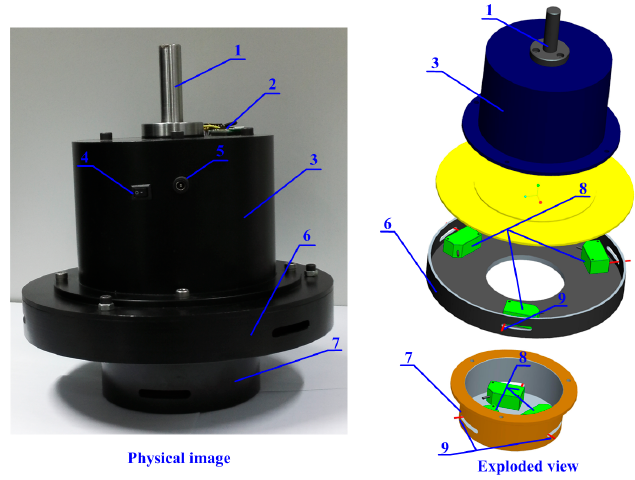
Figure 2. The laser-based measuring head. 1—joint rod, 2—Bluetooth, 3—data processing module, 4—power switch, 5—charging interface, 6—upper bore gauge, 7—lower bore gauge, 8—LDSs, 9—measuring lasers.